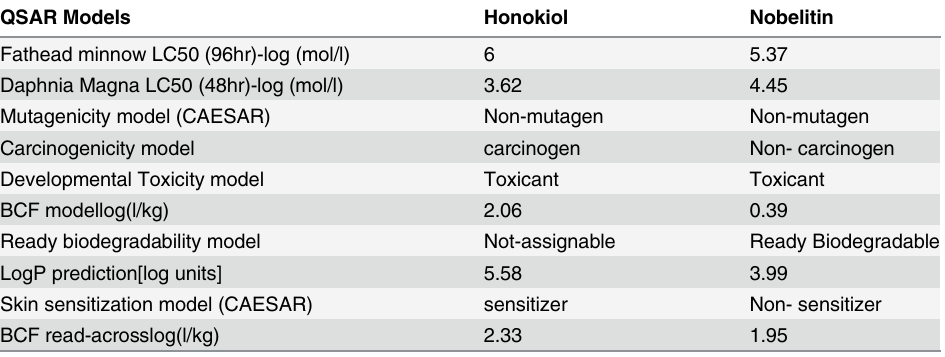
Table 6. QSAR predicted values for phenol compounds used for docking analysis and their applica- bility domain analysis for various models. QSAR